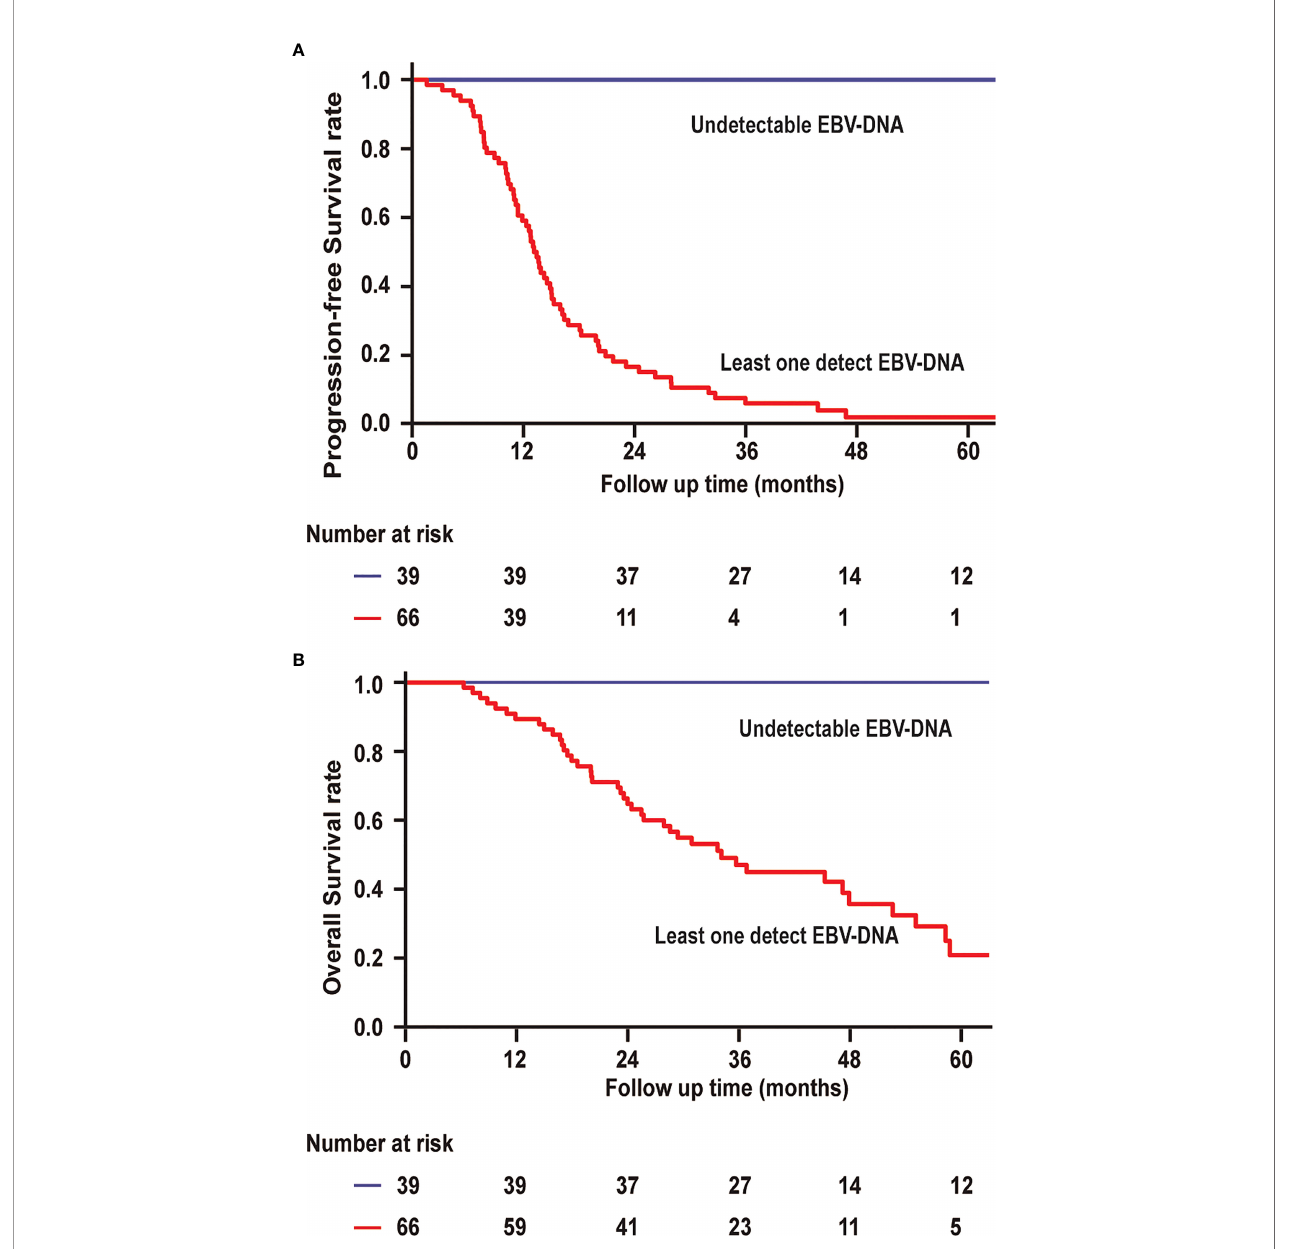
FIGURE 4 | (A) Progression-free survival and overall survival (B) of patients with undetectable EBV-DNA at all surveillance time points vs. patients with at least one EBV-DNA blood